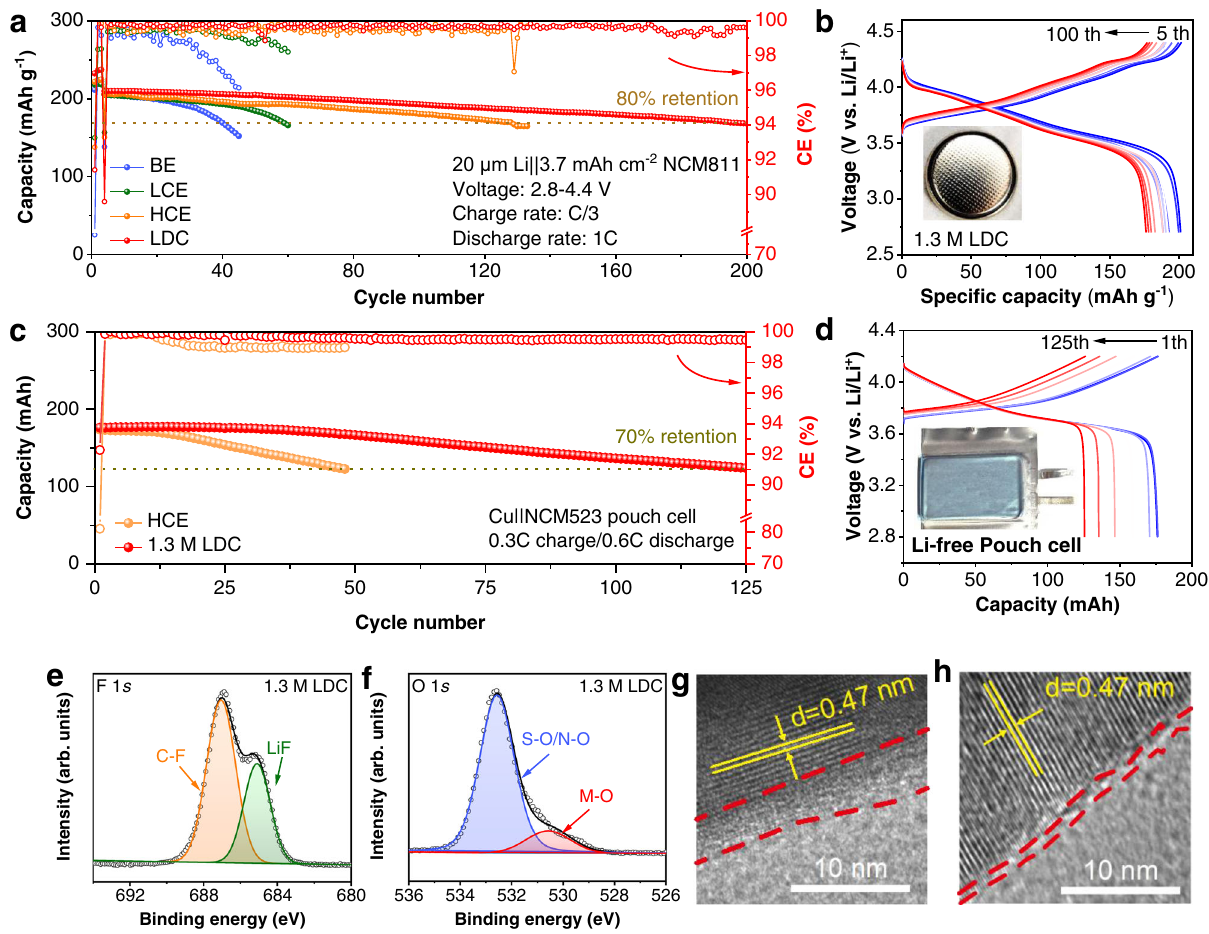
Fig. 6 | The performance and characterization of LMBs. a Li||NCM811 cells with differentelectrolytes(1C=200mAg − 1 ). b Voltagepro fi lesofLi||NCM811withLDC. c Cu||NCM523 pouch cells with HCE and LDC (1C=180mA was de fi ned for 180